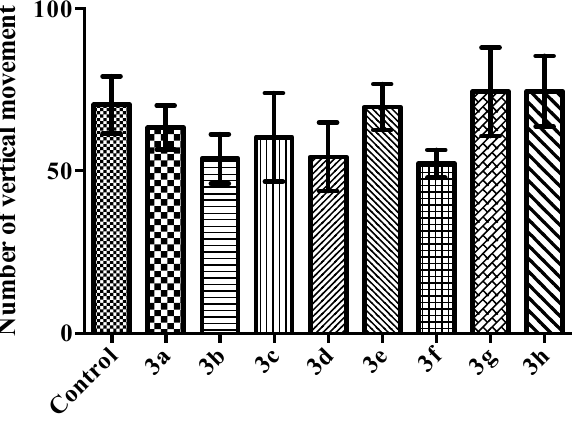
Figure 6. The effects of the test compounds 3a – 3h (40 mg/kg) on the vertical locomotor activities of the mice in activity cage test. Values are given as mean ± SEM, ( n = 6).